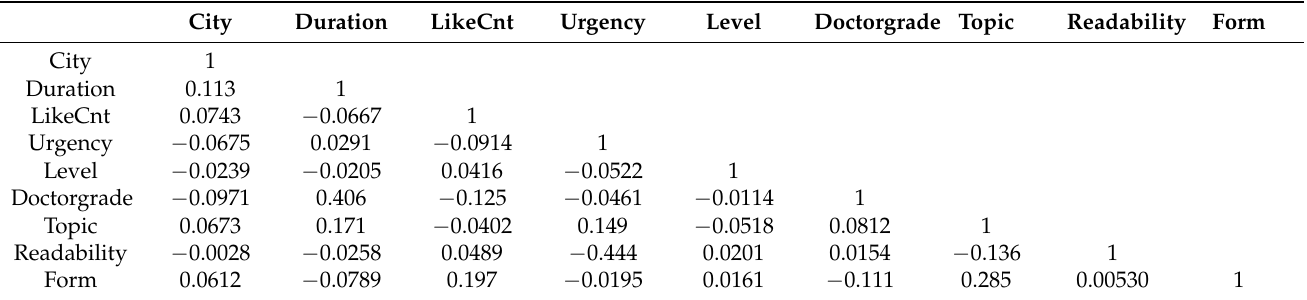
Table 4. Correlation Analysis.